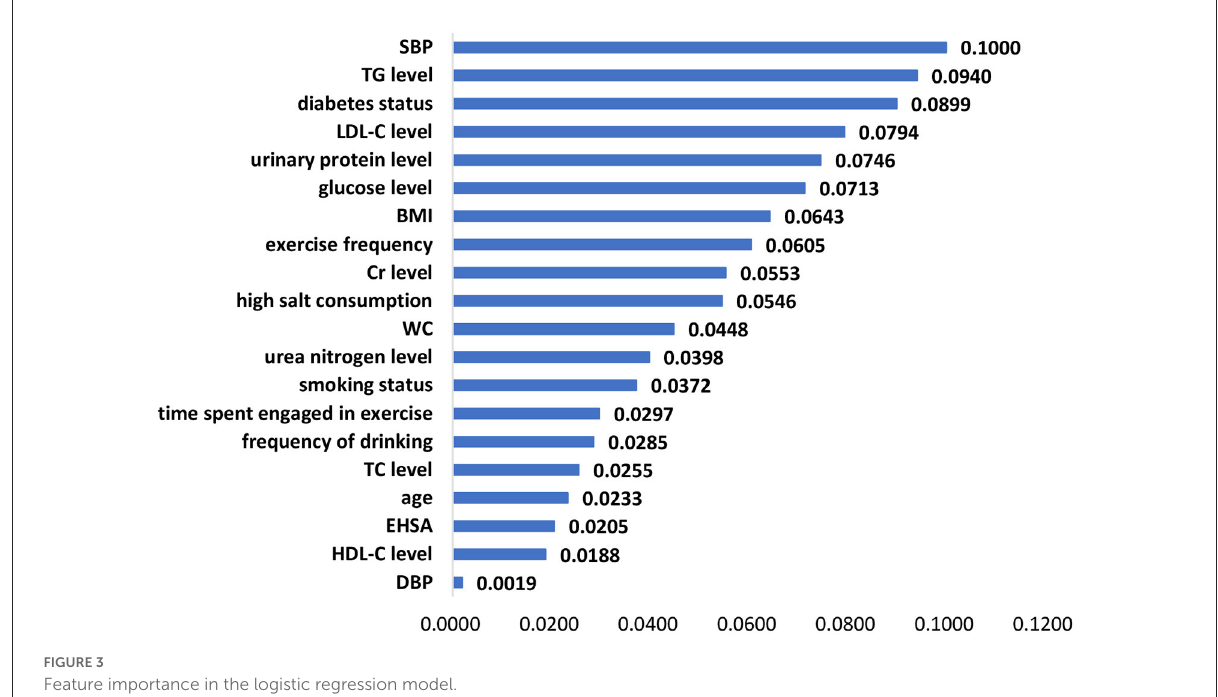
FIGURE3 Feature importance in the logistic regression model.